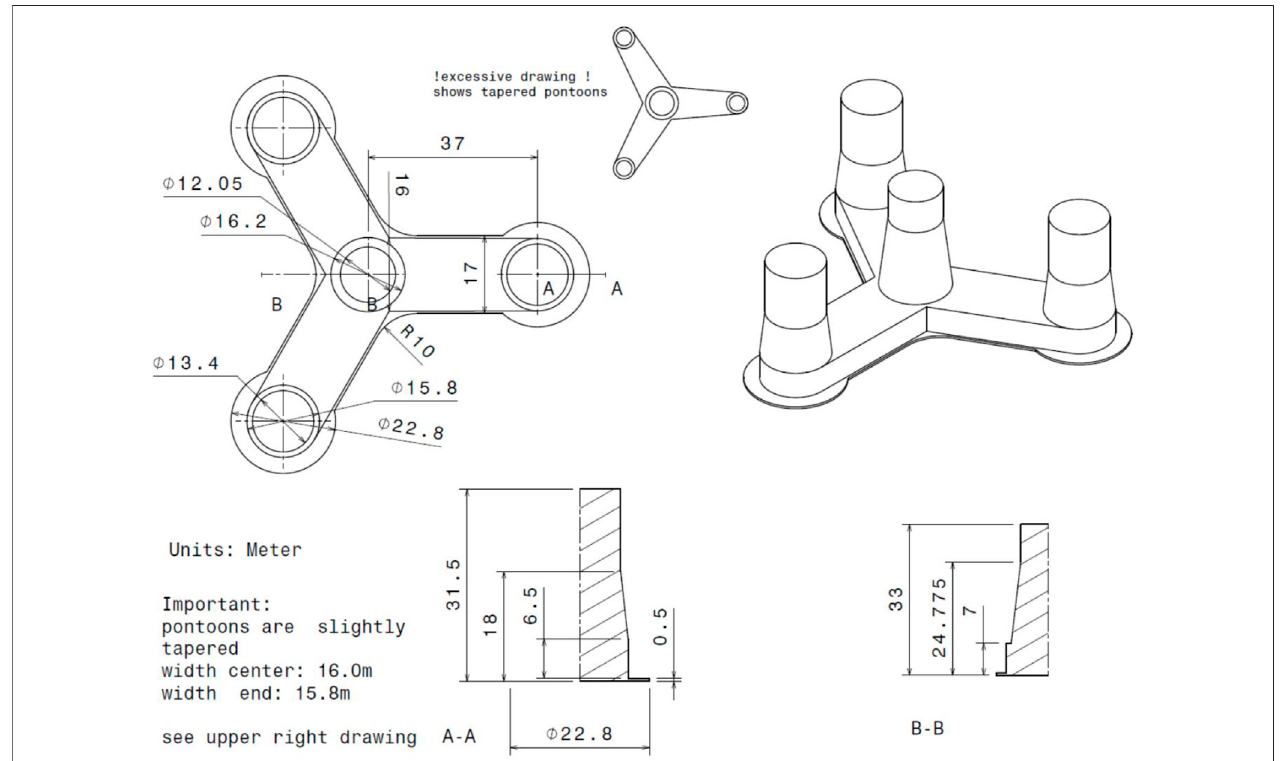
FIGURE 2 | Main dimensions of the OO-Star fl oater of the 10-MW wind turbine.